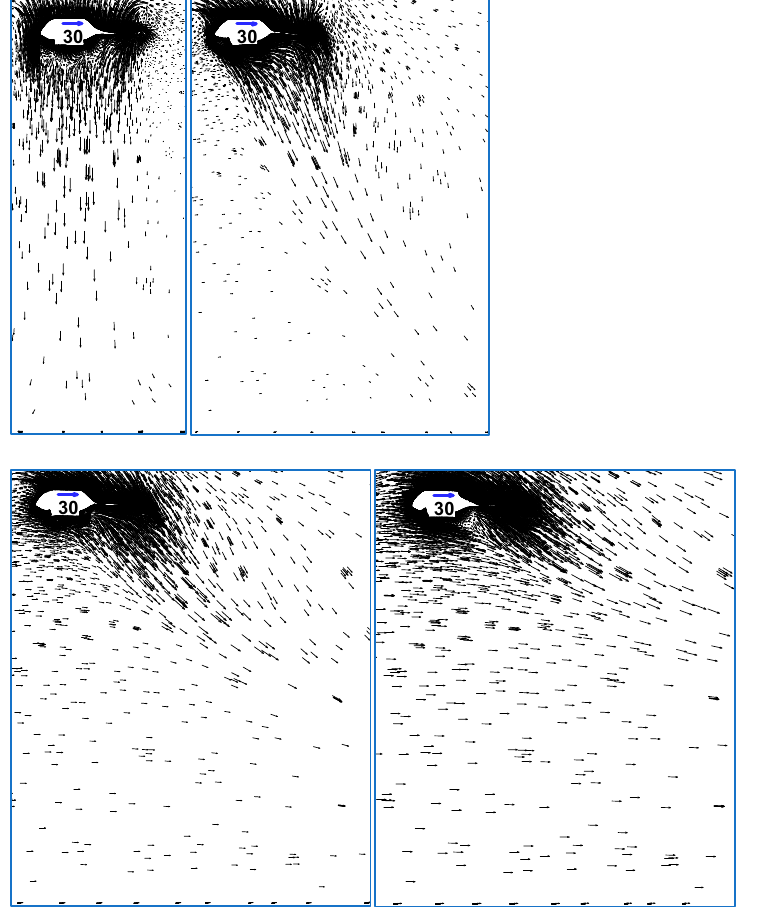
Figure 23. Distribution of wake flow when the helicopter tank bottom was 30 m above the ground (wind speed was 0 m/s, 5 m/s, 10 m/s, and 15 m/s; reference speed marked on the fuselage, indicated by a blue arrow, and the reference speed is 30 m/s).